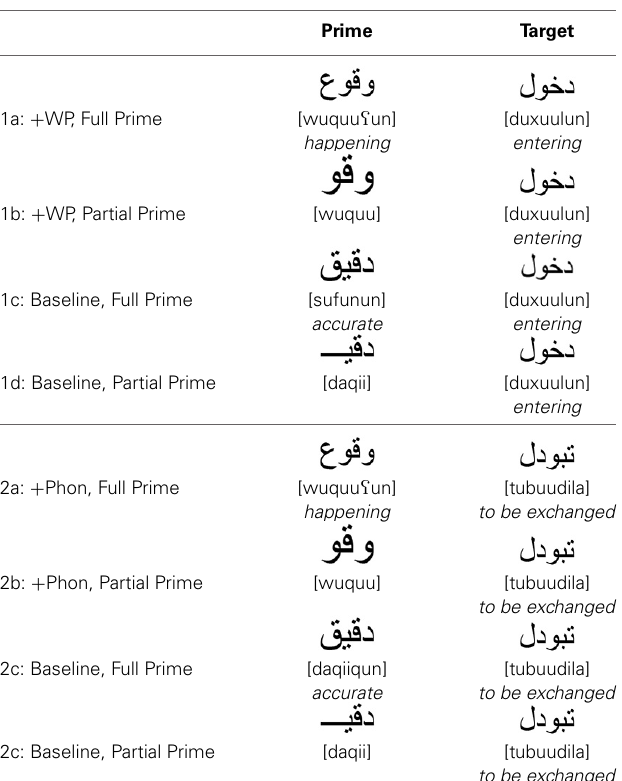
Table 3 | Sample stimuli used in the different conditions of experiment